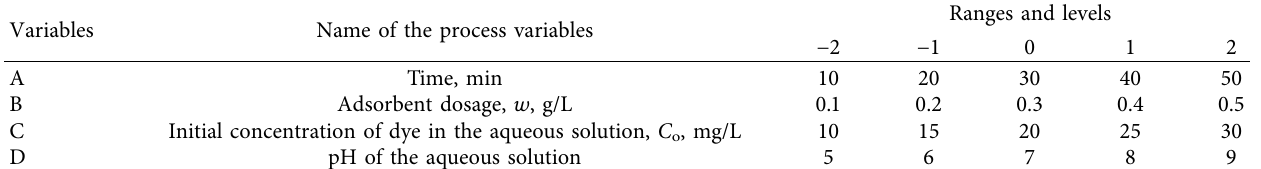
Figure 2: (a) FTIR of n-GO; (b) FTIR of Table 1: Levels of different process variables in coded and uncoded forms for adsorption.